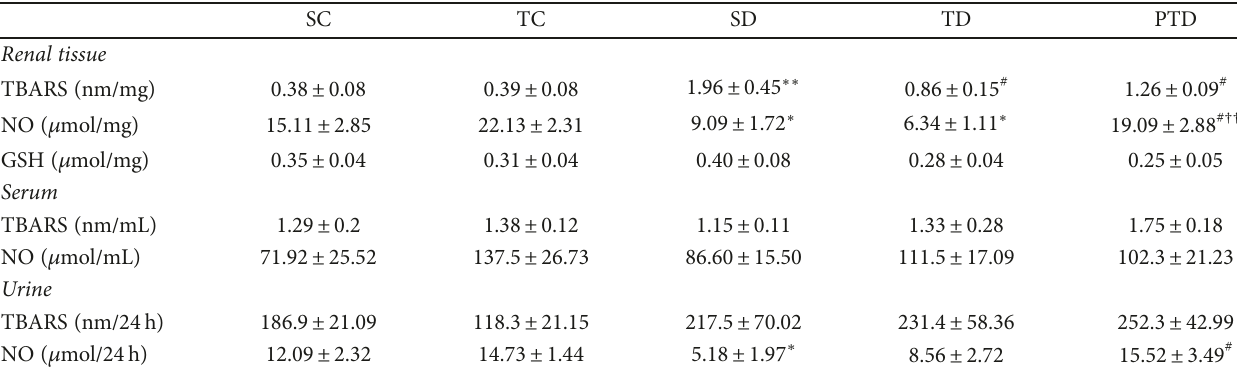
Table 2: TBARS and NO levels in serum, urine, and kidney and GSH levels in the kidney of SC, TC, SD, TD, and PTD rats. SC Renal tissue